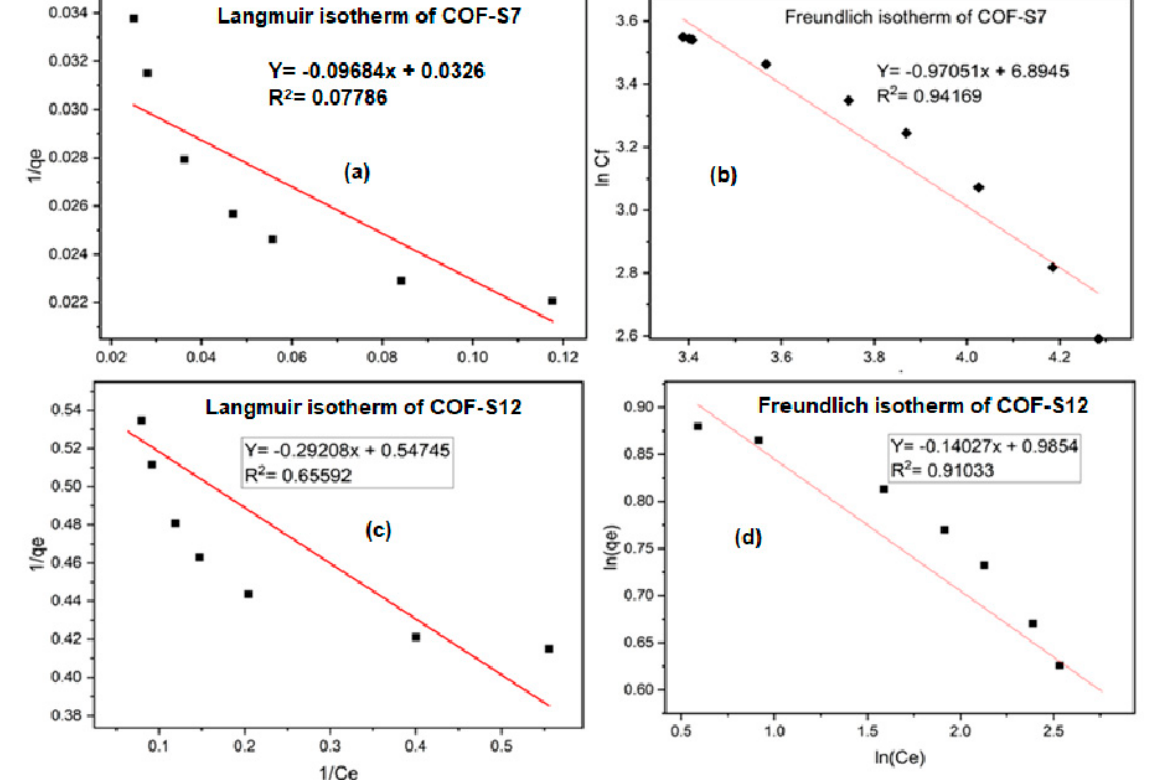
Figure 12. ( a , b ) Langmuir and Freundlich isotherm plot COF-S7 and ( c , d ) Langmuir and Freundlich isotherm plot of COF-S12, respectively, in naproxen removal at pH 7, dosage 0.05 g. Reusability is one of the most important criteria in the commercialization of adsor- bents since it is directly related to the adsorption procedure’s outlay efficacy. Therefore, the regeneration of COF-S7 and COF-S12 was investigated after washing the used ad- sorbent with ethanol. Desorption is anticipated to restore the new adsorbent’s ability. The regeneration evaluation was observed in five adsorption/desorption cycles [46,77] as loss in adsorption cycles, at 71.2 percent. In comparison, COF-S12 exhibited an